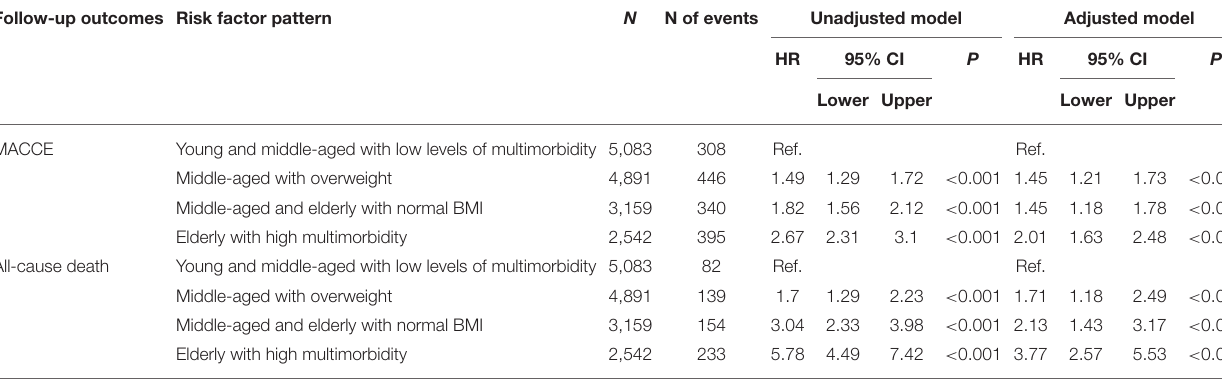
TABLE 3 | Association with risk factor patterns and outcomes. Follow-up outcomes Risk factor pattern N N of events Unadjusted model Adjusted model